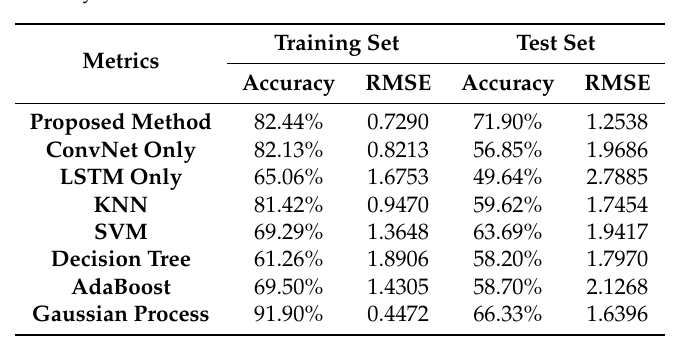
Table 1. Results of using all ten runs from 8 tracks as training set, and all ten runs from the other 1 track as test set. Proposed method (ConvNet + LSTM) are compared with various machine learning methods using accuracy and root mean square error (RMSE0 as metrics respectively; the performance is deemed better for higher accuracy and lower lower RMSE.